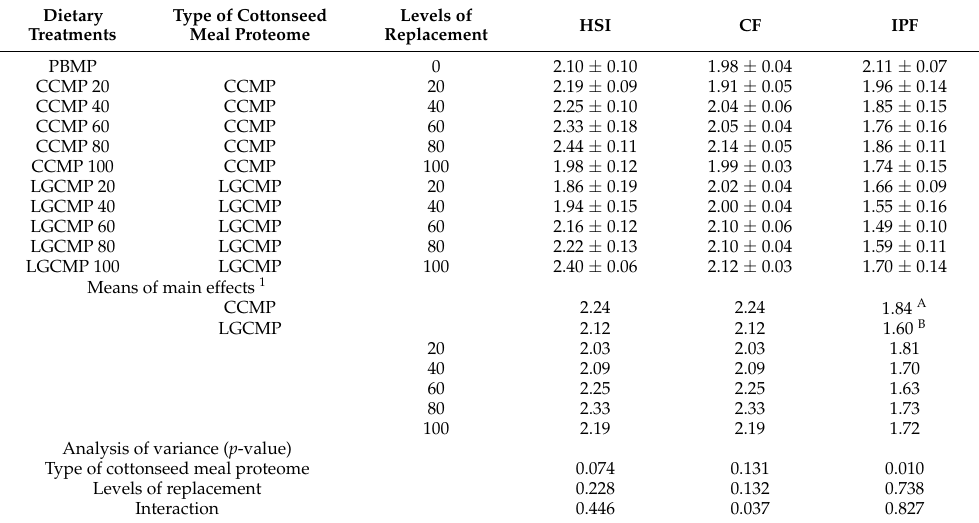
Table 4. Body condition indices of hybrid grouper juveniles fed different experimental diets for 9 weeks.